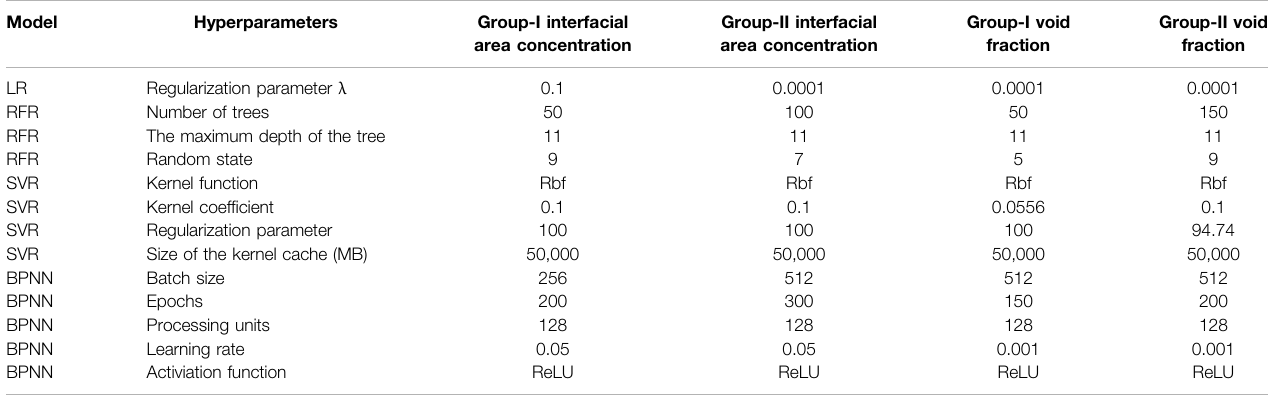
TABLE 2 | The selected hyperparameters for each